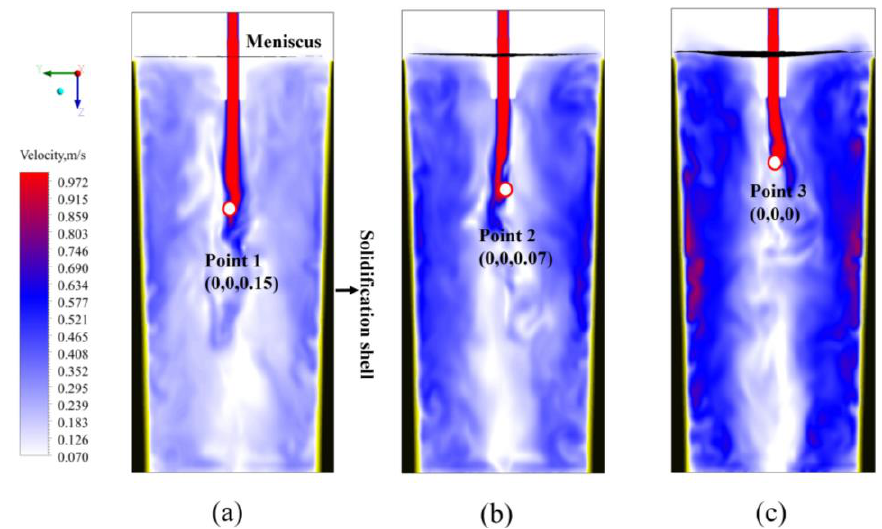
Figure 9. Transient contours of velocity at conditions of ( a ) 310 A/0.5 Hz, ( b ) 310 A/1.5 Hz, and ( c ) 310 A/2.5 Hz.